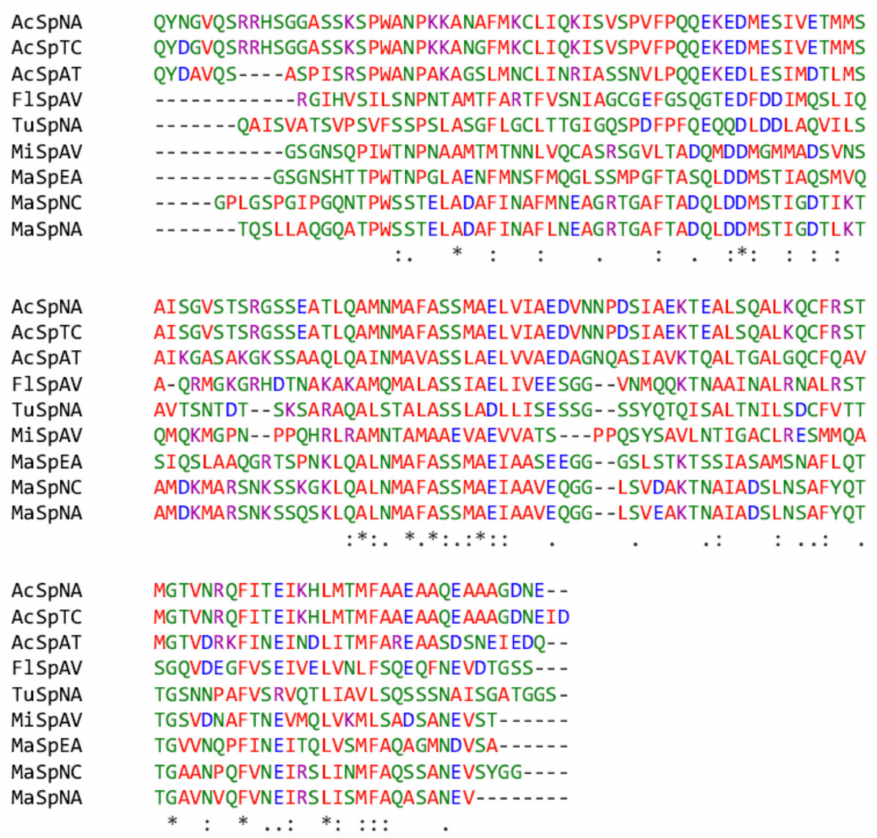
Figure 1. Sequence alignment of N-terminal domains of di ff erent types of spider silk proteins, including aciniform: AcSpNA, AcSpTC (genbank: AWK58691.1), and AcSpAT (AHK09776.1); major ampullate: MaSpNA, MaSpNC (PDB: 5IR2), and MaSpEA (PDB: 3LR2); minor ampullate: MiSpAV (PDB: 2MX8); flagelliform: FlSpAV (GBM14626.1); tupliform: TuSpNA (ACI23395.1). “*”, “:”, and “.” indicate perfect alignment, strong similarity and weak similarity,